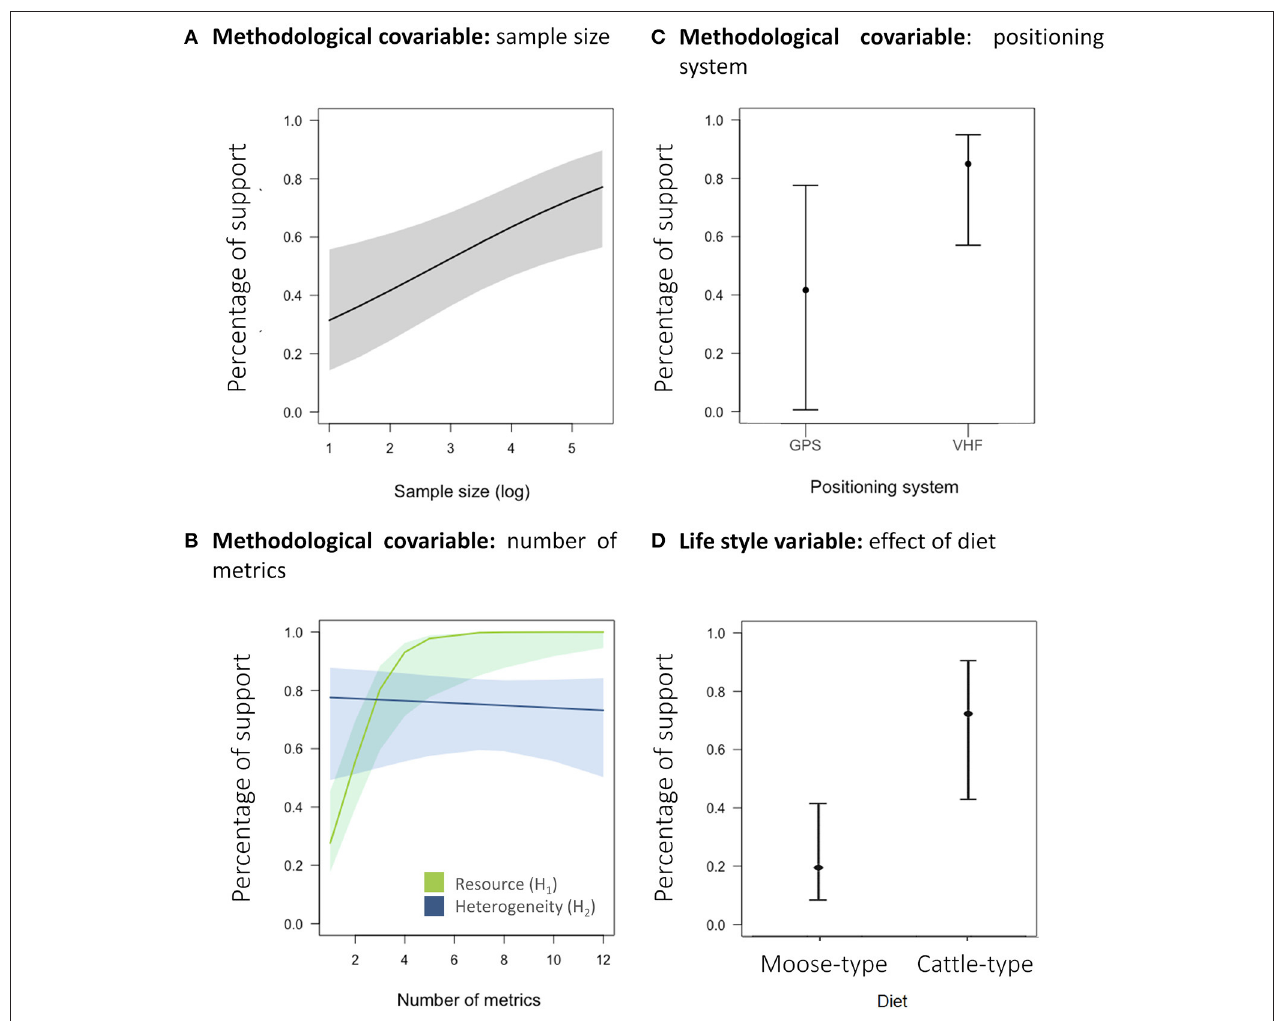
FIGURE 6 | Effect of (A) the sample size (log-transformed; if the positioning system was GPS, the season was the non-productive season, the number of metrics was 4.07 and the ecological driver was the resource one). (B) The number of metrics tested [if the sample size was 3.06 (log-transformed), the positioning system was GPS and the season was the non-productive season] on the probability to have at least one metric supporting the biological hypotheses. These results correspond to the model that explains the probability of support for each hypothesis according to the different methodological features accounted for differences among case studies. (C) The positioning system [if the season was the non-productive one, the number of metrics was 4.07, the ecological driver was the resource one, and the sample size was 3.07 (log-transformed)]. (D) Effect of diet [if the positioning system was GPS, the sample size was 3.18 (log-transformed) and the season was the non-productive season] on the probability to have at least one metric supporting biological hypothesis. This model was performed on a subset of our sample with the resource hypothesis only and the case studies studying the two seasons. The response variable for the four panels is binomial, whereby 0 means that the authors concluded that their hypothesis was not supported, and one otherwise (see Figure 1 ). The shades in ( A and B ) correspond to the 95% confidence